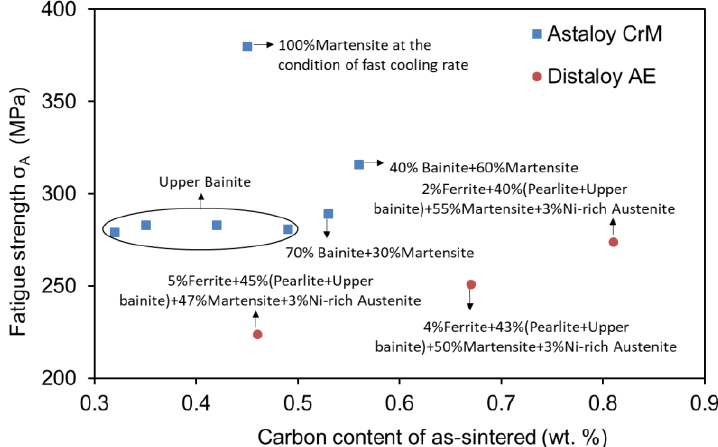
Figure 4. The variation of fatigue strength ( σ A ) with the composition of complex phases with different carbon contents.